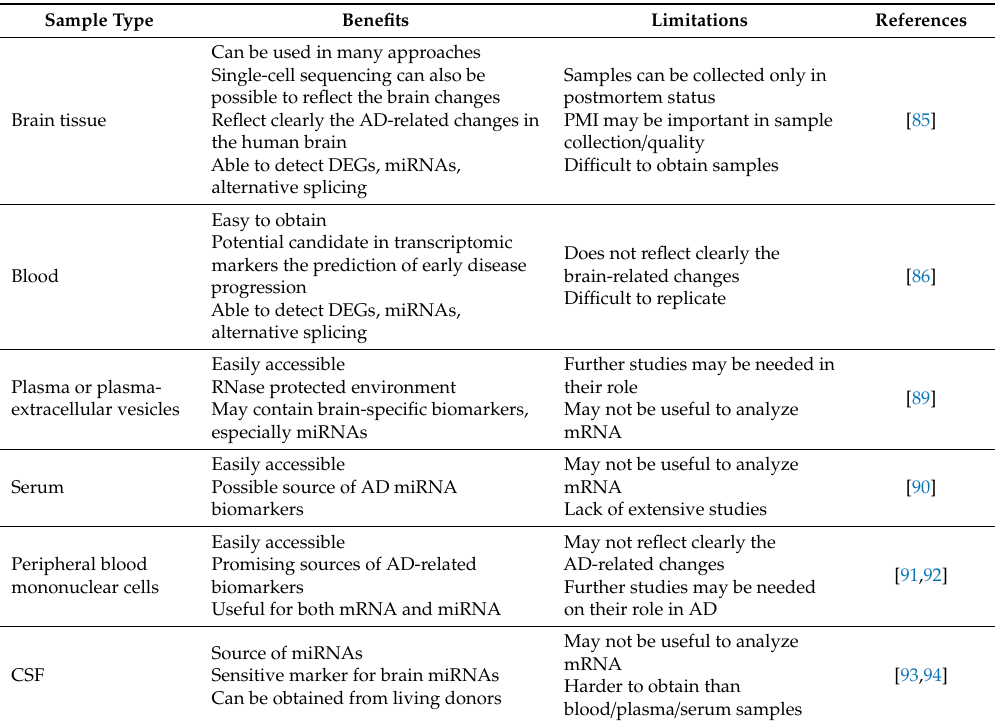
Table 2. Sample types used in AD-transcriptome